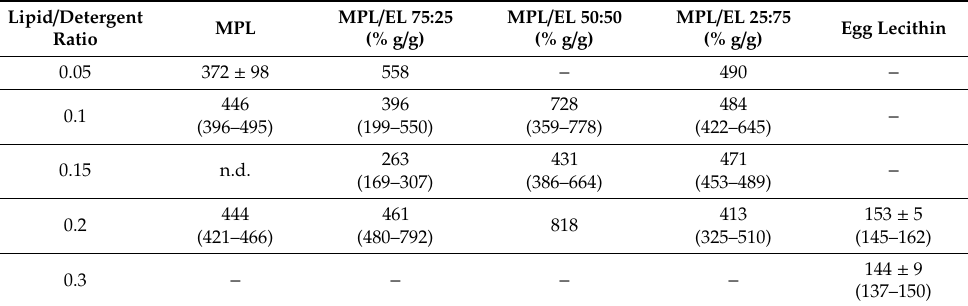
Table 10. Mixed liposomes, average